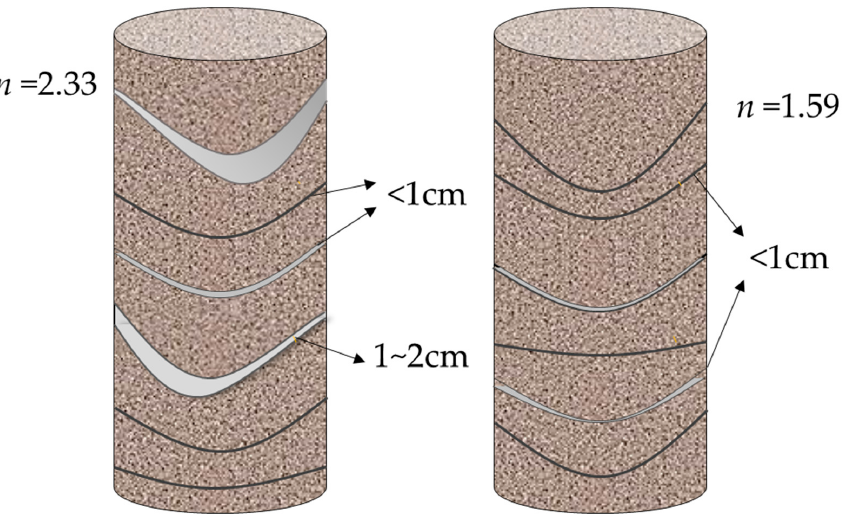
Figure 6. Schematics of different fracture width patterns in a fixed test interval.